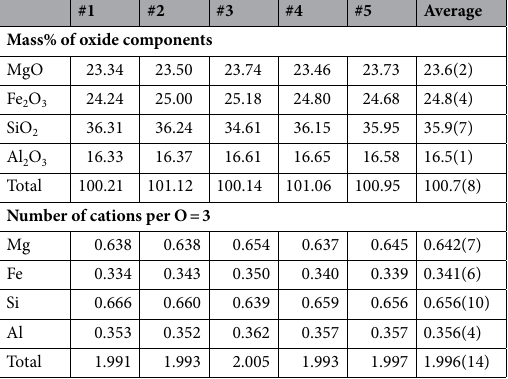
Table 1. Compositions at five analysis-points (#1–#5) from EPMA and the average of